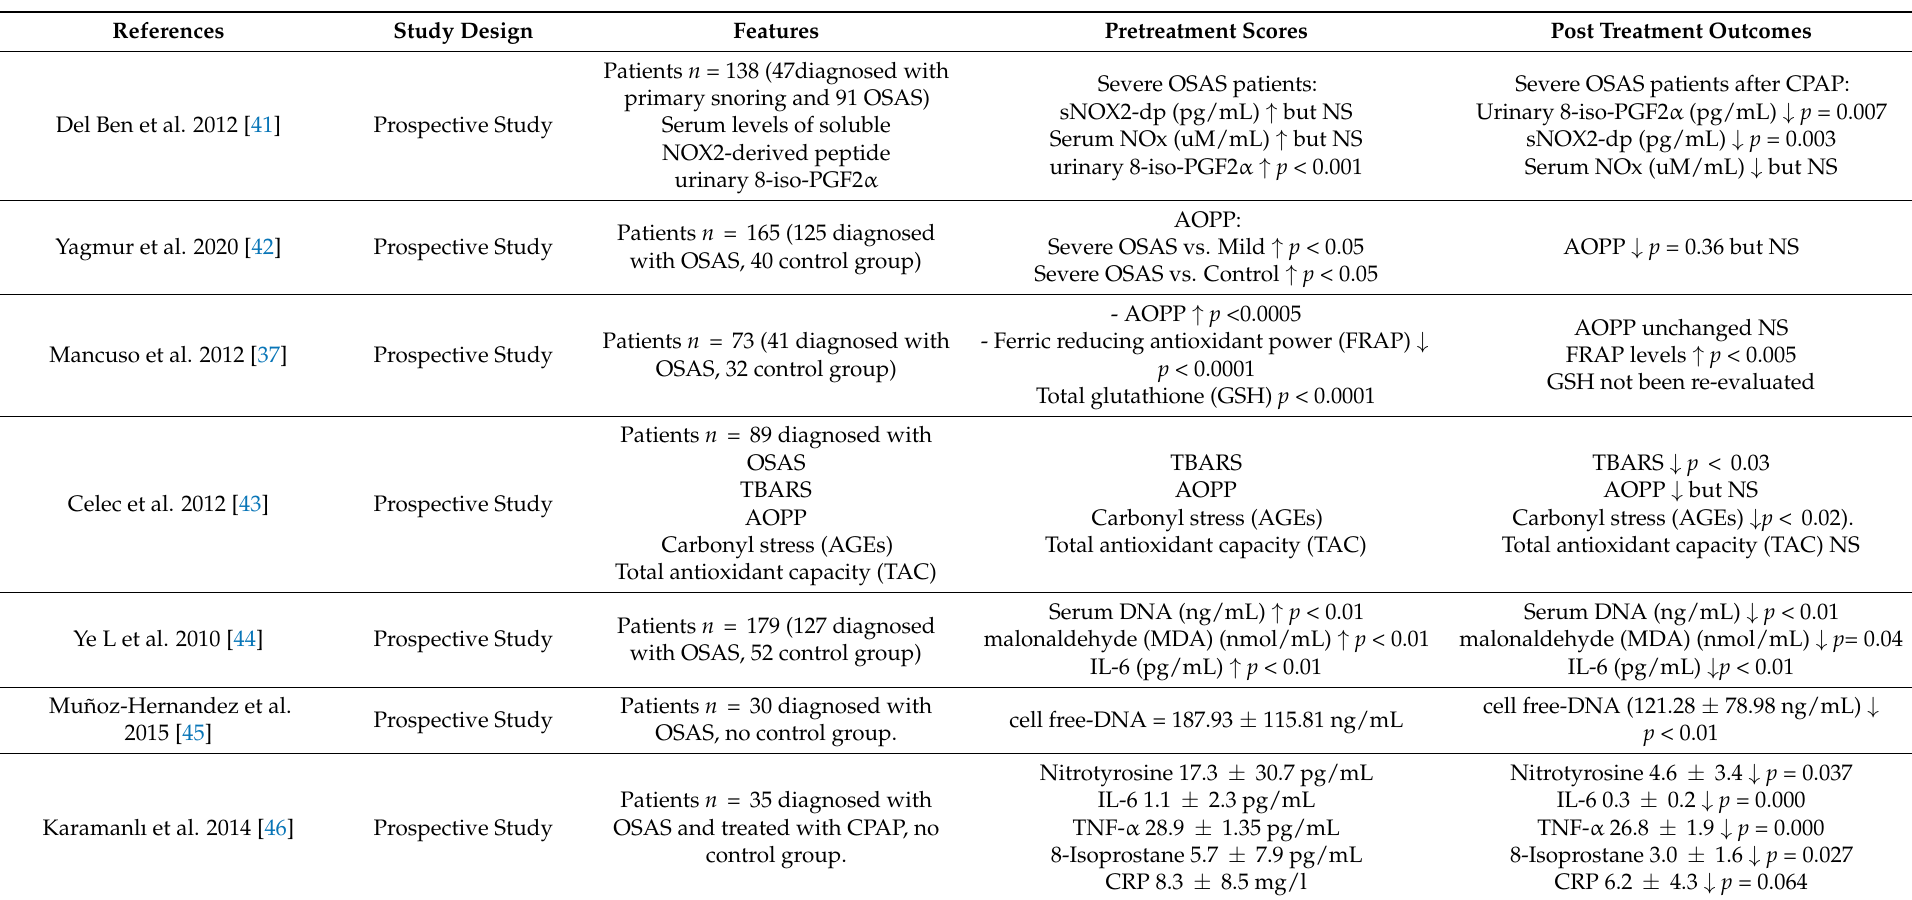
Table 3. Response to CPAP treatment on Oxidative Stress Biomarkers in Prospective Studies. Abbreviations: NS, not